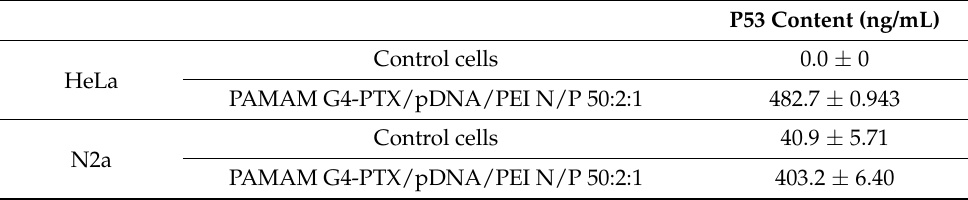
Table 2. Quantification of p53 protein levels (ng/mL) in HeLa and N2a cancer cells after 48 h of transfection mediated by PAMAM G4-PTX/pDNA/PEI complexes prepared at N/P ratio of 50:2:1. The values were calculated with the data obtained from three independent measurements (mean ± SD, n =